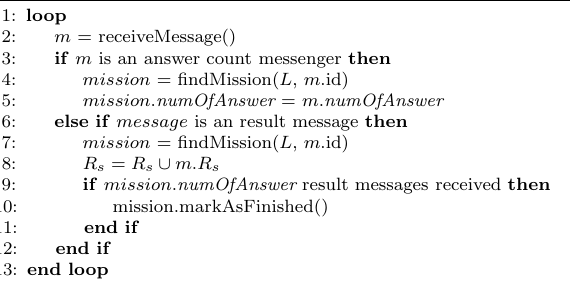
Algorithm 4 Receiving WP Algorithm